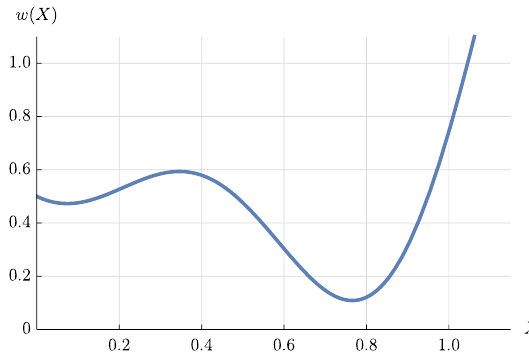
Figure 1 . Random graph as example for w ( X ) with asymptotic behavior X 2 . Coming from infinity the first extremum on the right necessarily is a minimum and thus not a dS 2 fixed